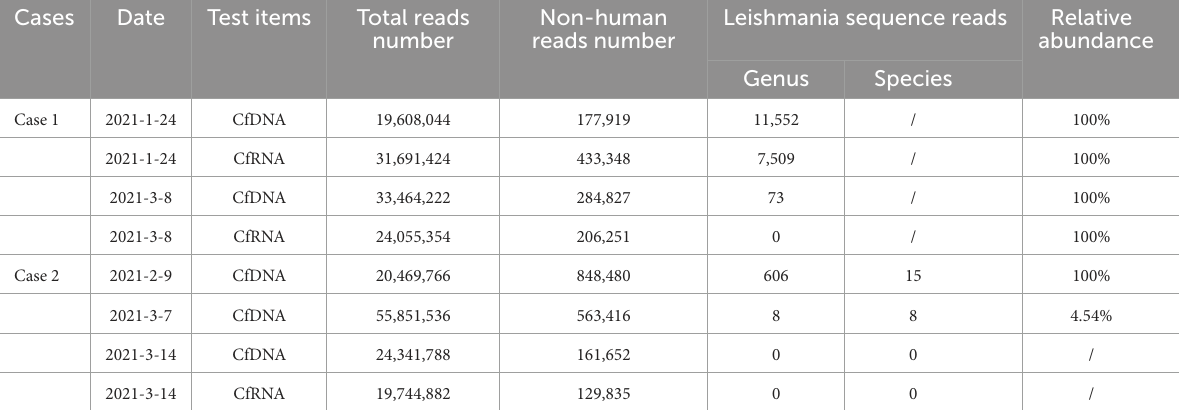
TABLE 3 Data and information of mNGS detection.